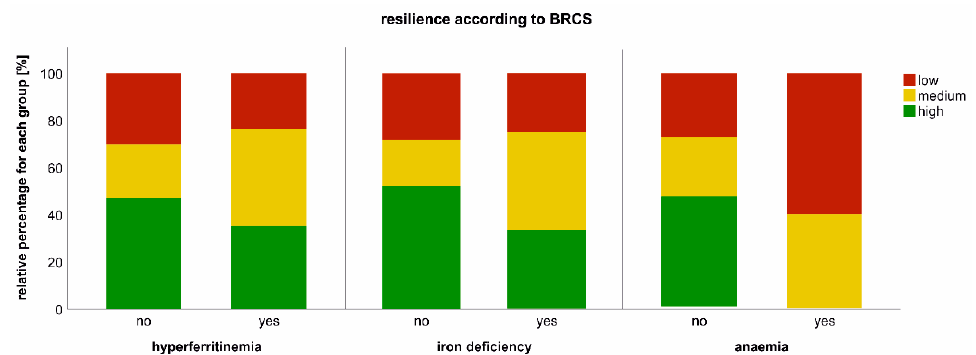
Figure 5. Impact of iron dyshomeostasis and anaemia on resilience at long-term post-COVID-19 follow-up. Resilience was evaluated with Brief Resilient Coping Scale (BRCS, low (4–13 pts), medium (14–16 pts) and high resilience (17–20 pts)) at the 360 days post-COVID reassessment according to the presence of hyperferritinaemia, iron deficiency or anaemia are depicted.